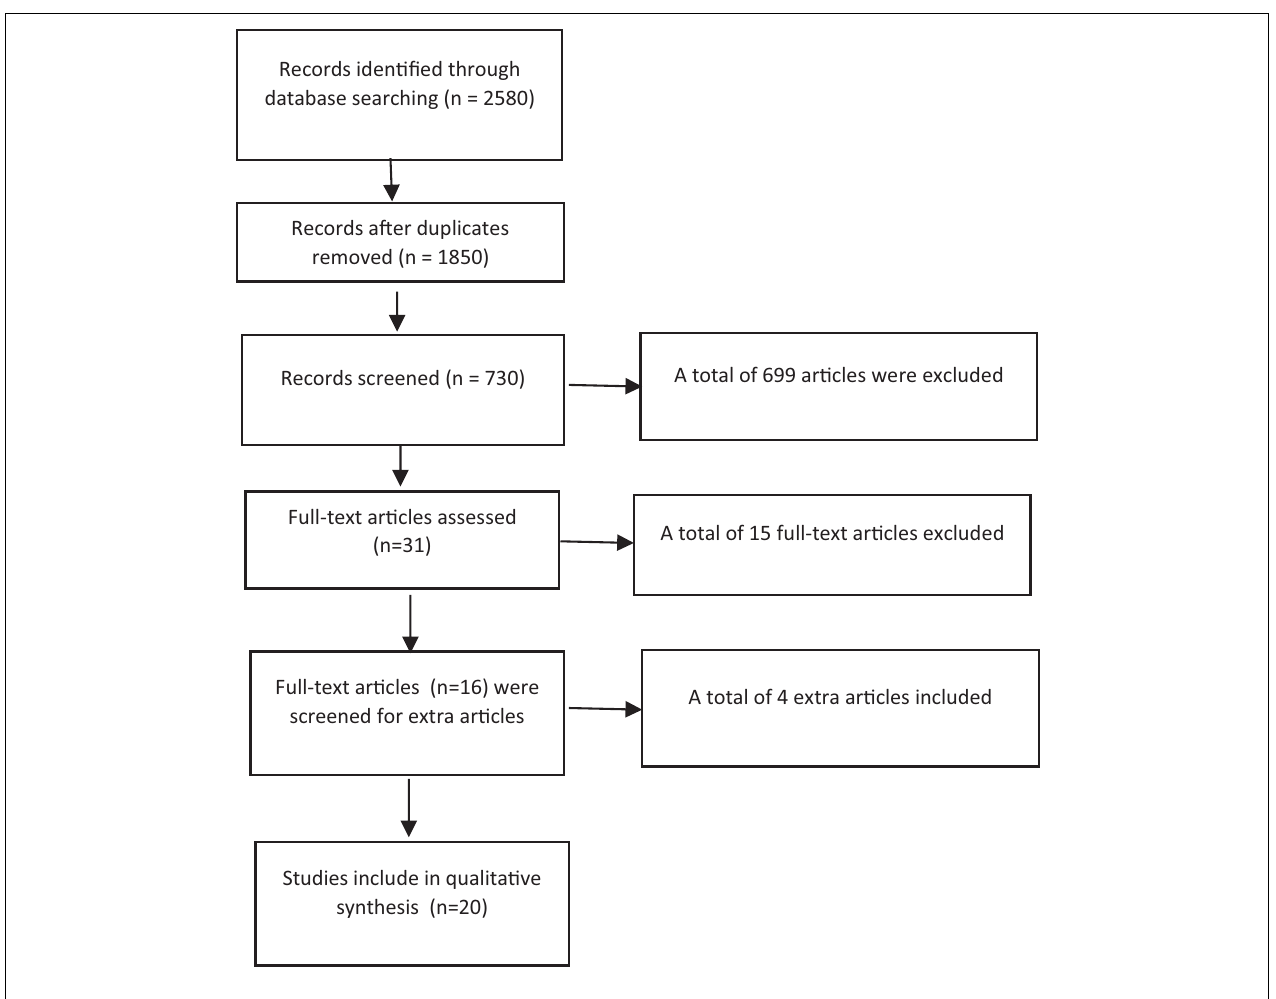
FIGURE 1 | Prisma Chart of literature